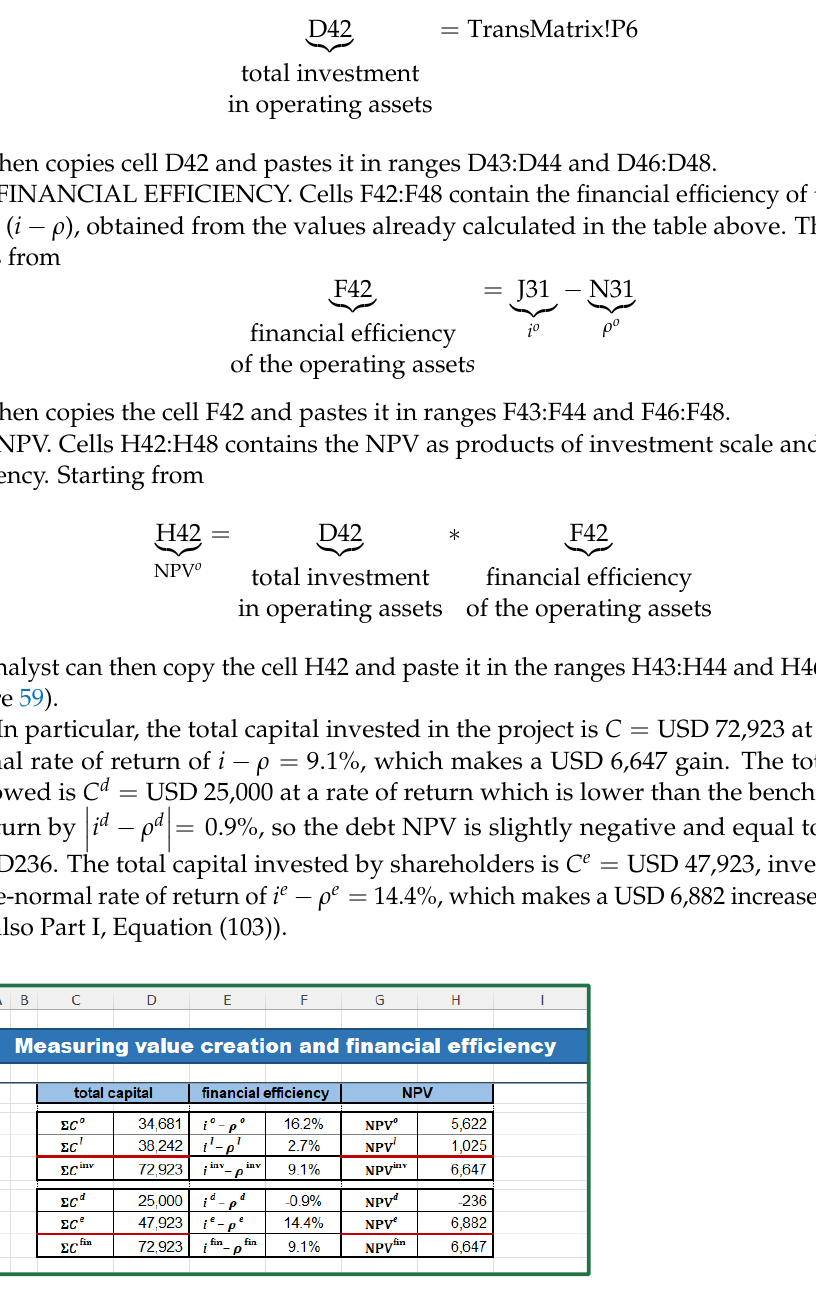
Figure 59. The product structure: an alternative way of calculating the NPV (“ValueCreation” sheet). (The red lines represent equality.)